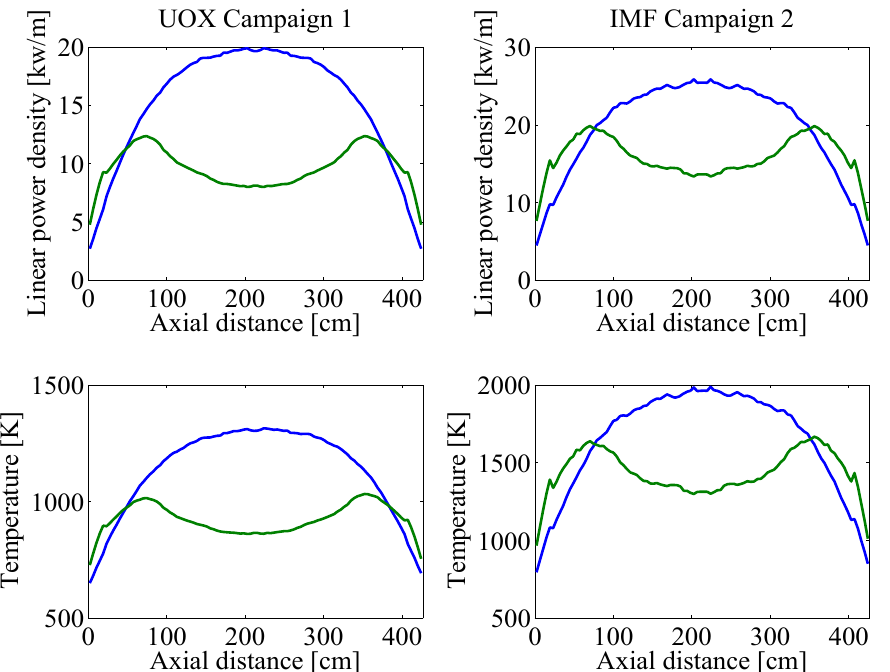
Figure 4. Effect of burnable absorber. The axial power profile and temperatures are shown at startup for the beginning of life uranium and hottest inert matrix fuel assemblies. Axial grading reduces the power peaking by more than 5% and lowers the inert matrix fuel maximum temperature by 200